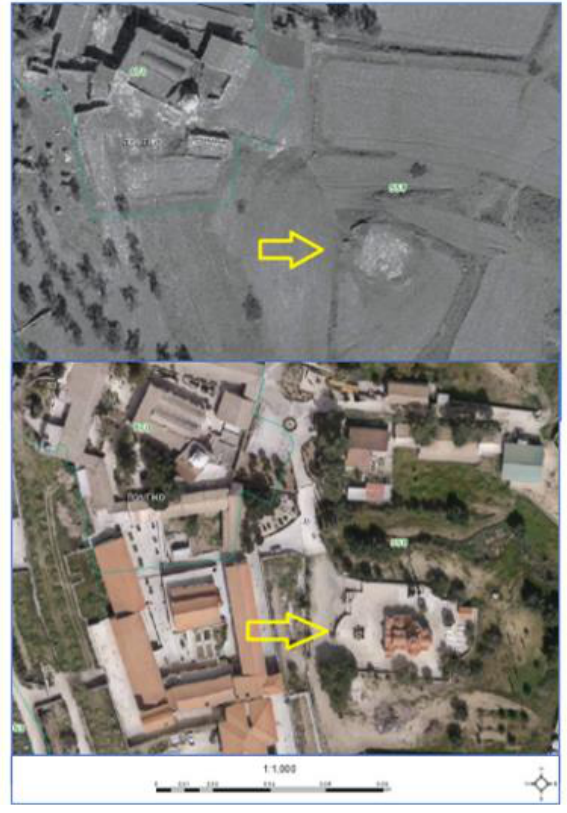
Figure 9. Threshing floor detected in 1963 photography in Politiko village. Today there is a church on that area.